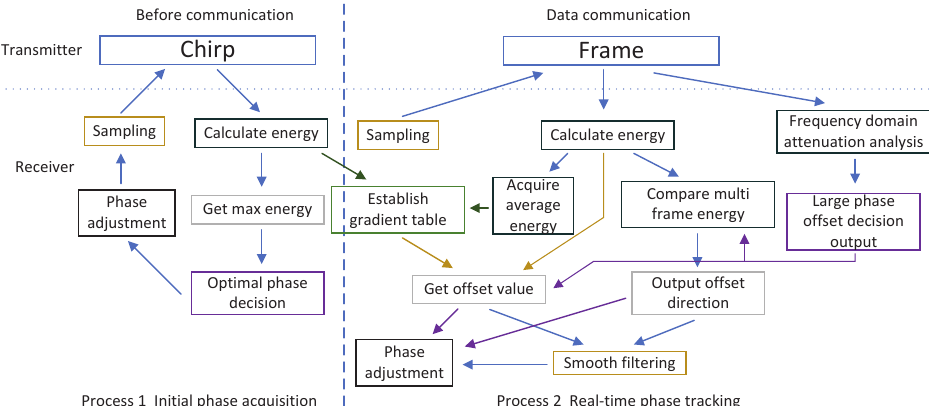
Figure 9. The main procedures of phase acquisition and tracking